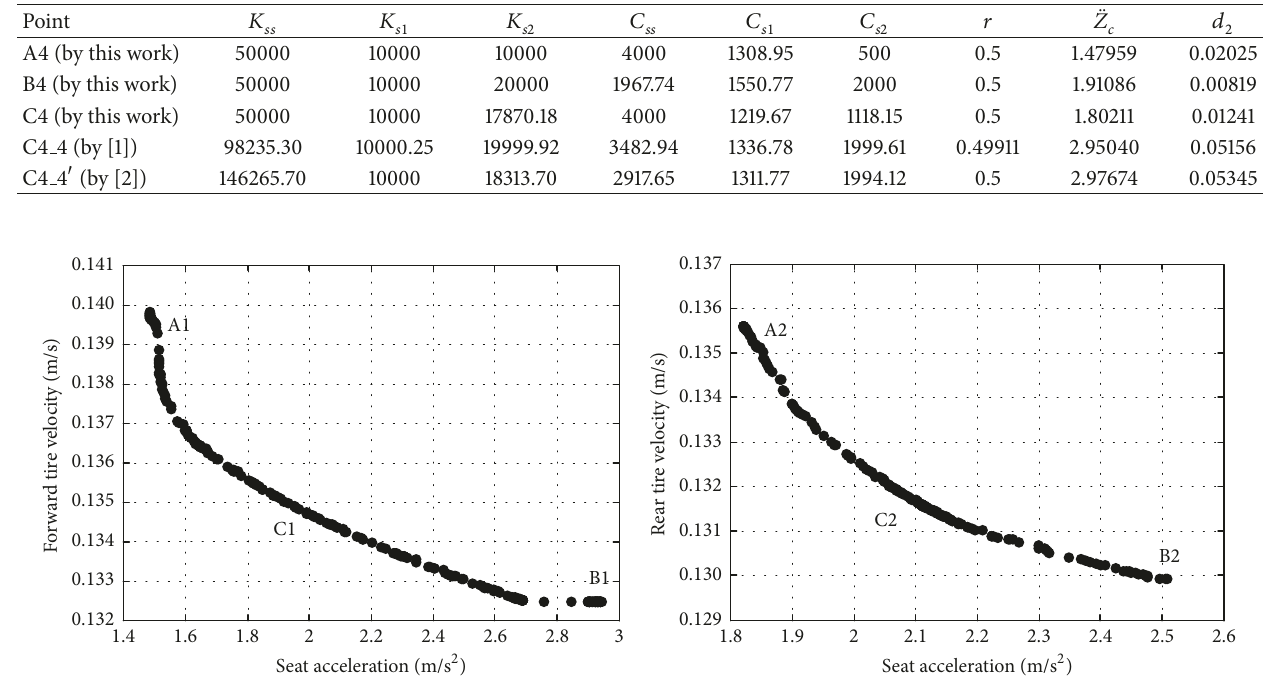
Figure 15: Obtained Pareto front for seat acceleration and forward/rear tire velocity.